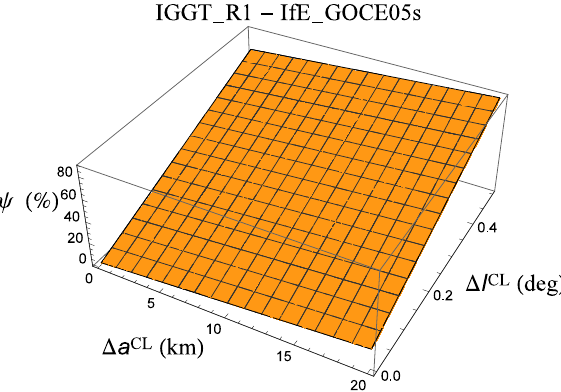
Figure A2. Percent systematic error ψ in the total L + CL Lense–Thirring node shift due to the mismodeling in J 2 calculated with Equation (6) as a function of ∆ a CL , ∆ I CL . The absolute value of the difference ∆ C 2,0 between the estimated values of C 2,0 of the IGGT_R1 [47] and IfE_GOCE05s [48] tide-free models is assumed as representative of the uncertainty δ C 2,0 . Cfr. with Table A3.